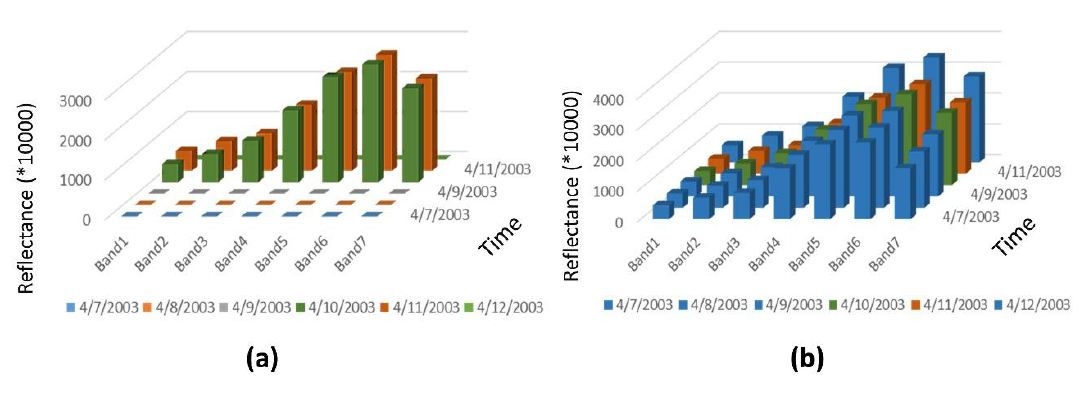
Figure 11. Data-gap filling at a given location (87.693245°W, 40.614263°N) in one rain event (from 7 April 2003 to 12 April 2003). ( a ) Incomplete dynamic soil feedback pattern before gap filling; ( b ) Feedback pattern after gap filling. Predicted reflectance is shown with blue